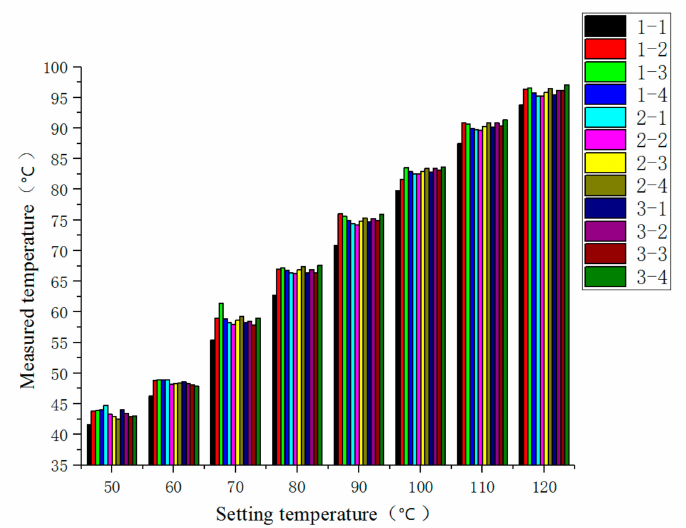
Figure 11. Steady-state measurement results of the temperature at each measuring point.